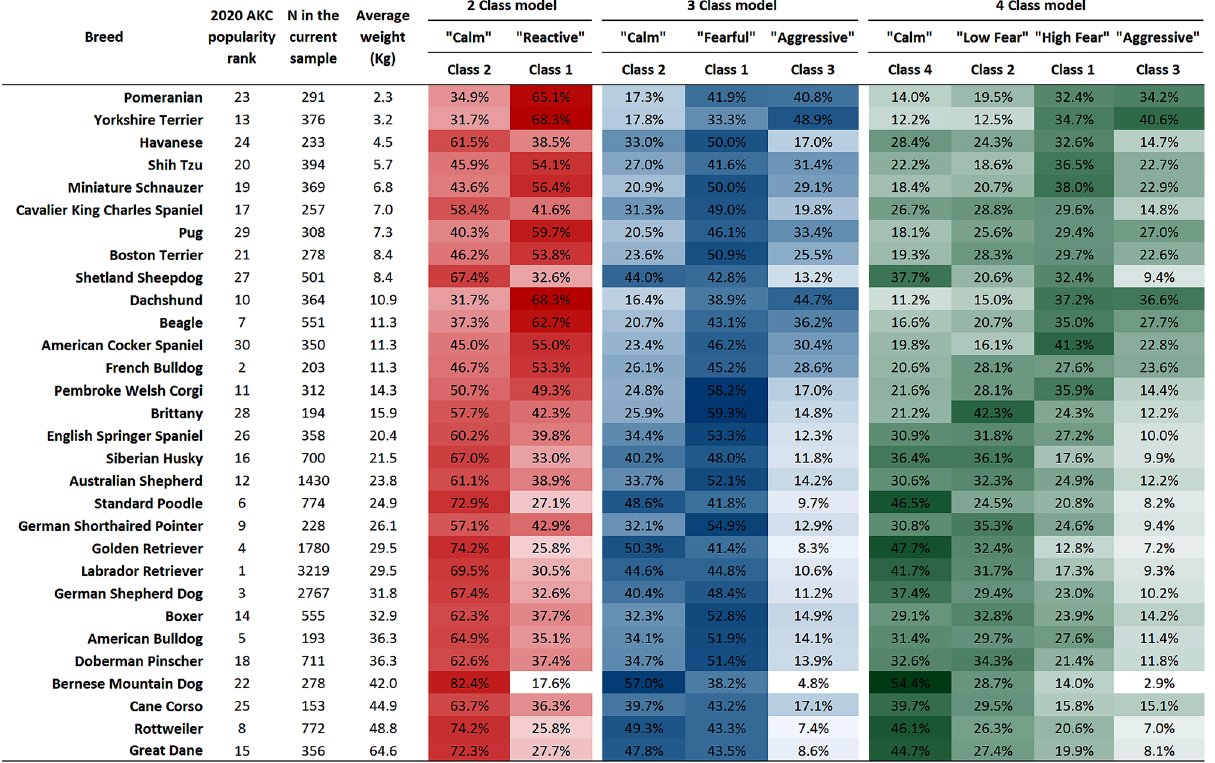
Figure 4. Proportional allocation by class of the top 30 most popular breeds sorted by average weight. Since class numbering is arbitrary by default, it was rearranged by desirability for this figure. Most desirable class is arranged left to right. Each class was summarized by a subjective adjective interpreted from the profiles they